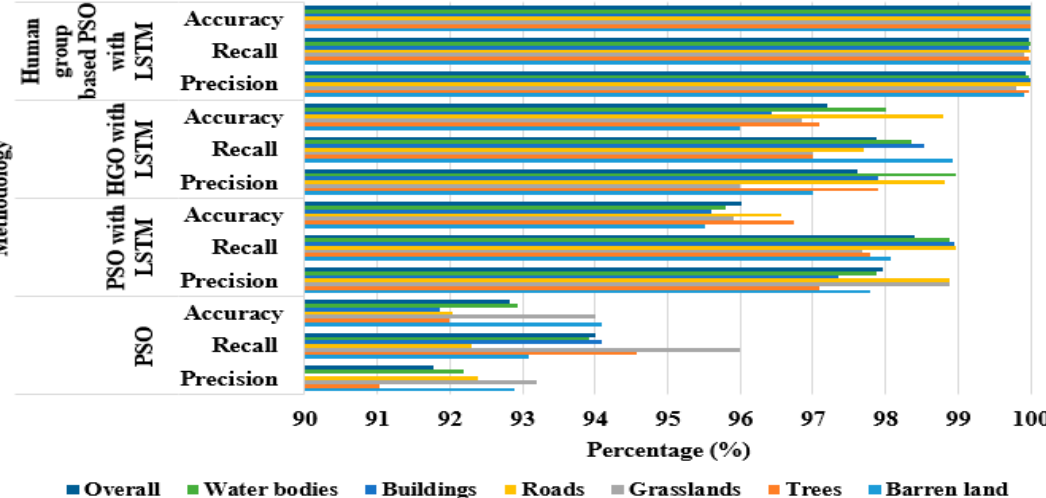
Figure 12. Graphical investigation of the proposed model with different optimization techniques on Sat 6 dataset.